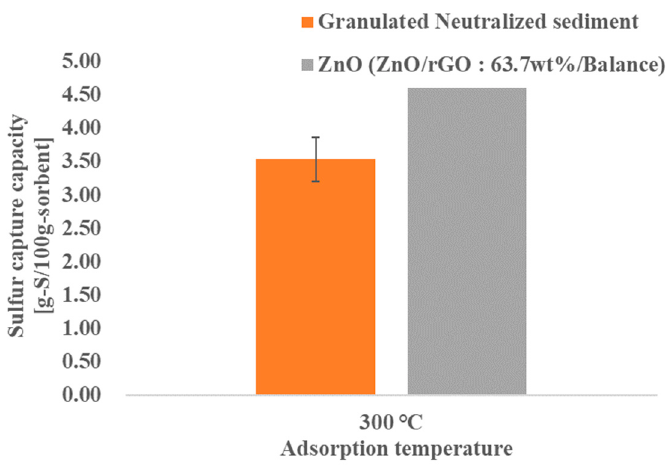
Figure 6. Comparison of performance between conventional and proposed adsorbents.